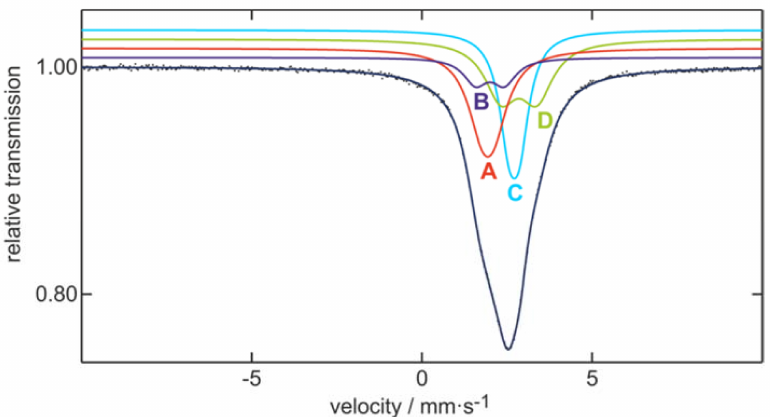
Figure 5. Experimental (data points) and simulated (continuous lines) 119m Sn Mössbauer spectrum of {Sn 10 [Ge(SiMe 3 ) 3 ] 4 } 2– at 6 K. For the fitting parameters, see Table 4.